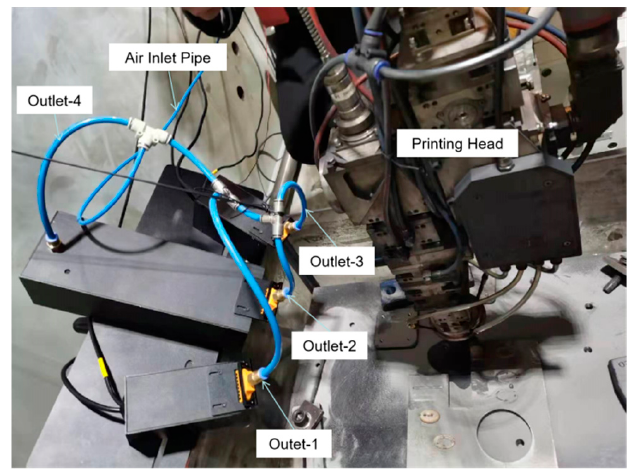
Figure 11. Working environment for the additive manufacturing of metal plates.